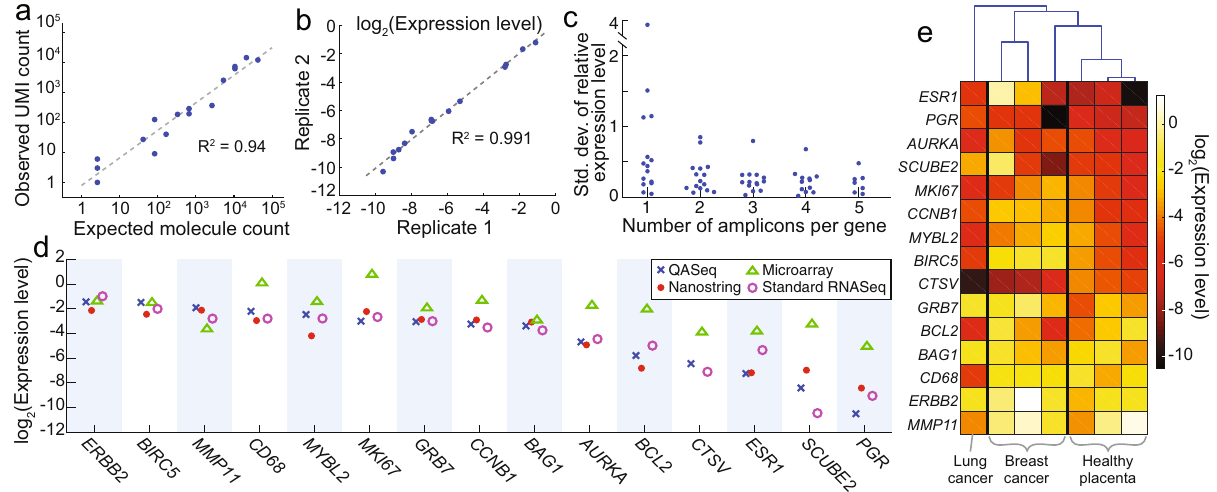
Fig. 4 RNA QASeq for gene expression level quantitation. a Quantitation accuracy validation with ERCC spike-in reference sample. b RNA QASeq quantitation reproducibility in technical replicates. 10 ng total liver RNA was used as input. c Multiple amplicons per gene reduced quantitation variability in technical triplicate analysis of total liver RNA sample. The standard deviation for relative expression level in triplicate experiments became lower as the number of amplicons per gene increased from 1 to 5. Only the amplicons at 5 ′ end of mRNA were used when analyzing a subset of amplicons. d RNA relative expression level quantitation side-by-side comparison using four different methods in one breast cancer FFPE RNA sample. e Relative expression level measured by RNA QASeq in four clinical FFPE tumor tissue samples and three normal placenta FFPE samples. Hierarchical clustering indicated the expression patterns were the most similar between normal placenta